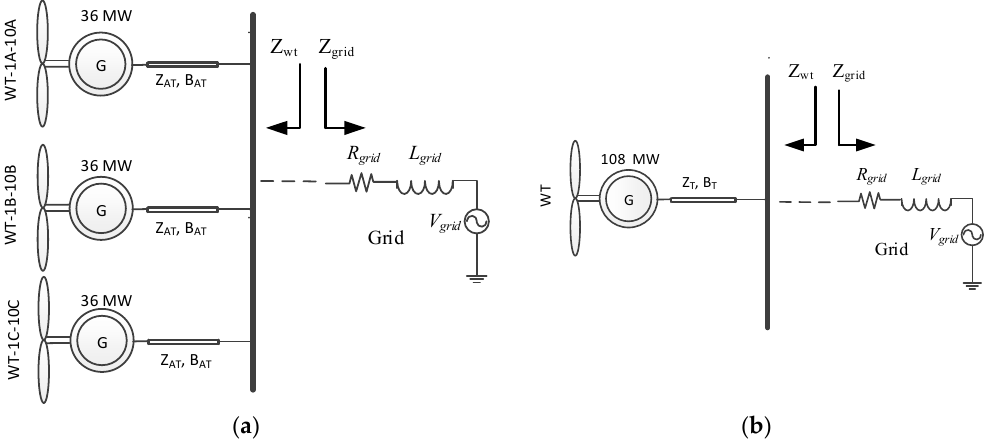
Figure 7. Aggregated model of the 108 MW wind power plant shown in Figure 8, ( a ) aggregated model on each string as one 36 MW wind turbine, ( b ) aggregated model of three strings into one 108 MW wind turbine.